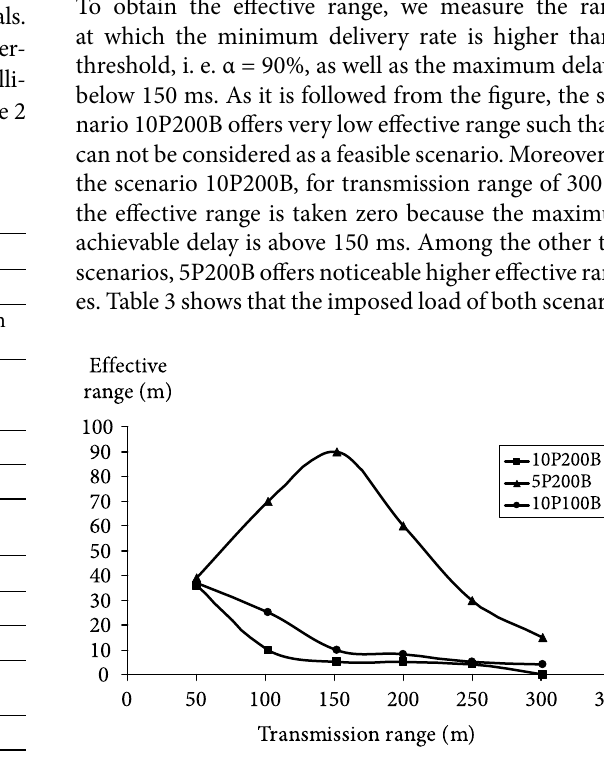
Fig. 3. Effective range of the beacon dissemination